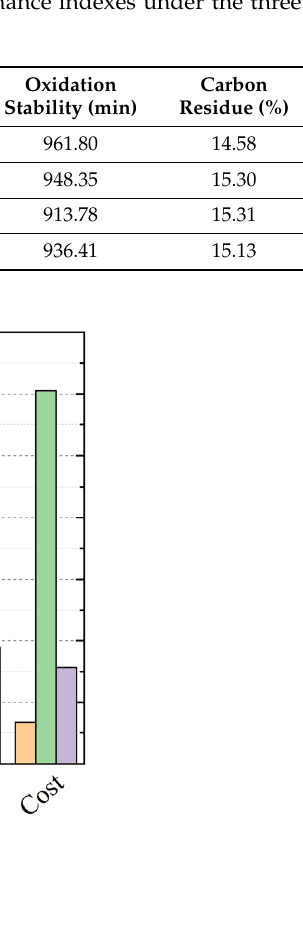
Table 6. Comparison of the calculated and required values of product performance indexes under the three blending schemes.